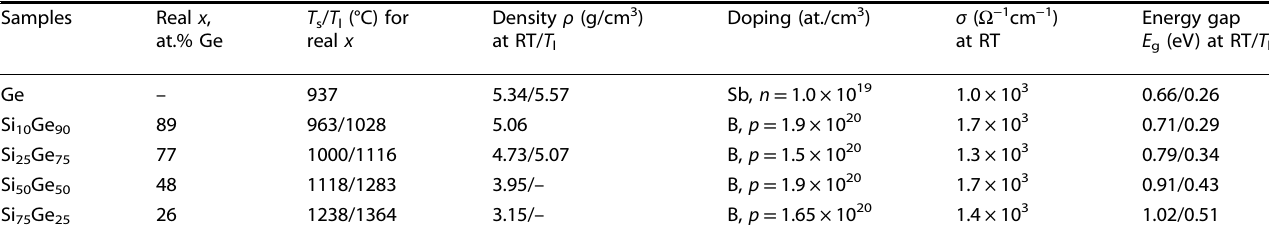
Table 1. Solidus and liquidus temperatures T s / T l , dopant concentration and electrical conductivity σ as well as energy gaps E g of Si 1 − x Ge x semiconductor samples used T s / T l (°C) for Density ρ (g/cm 3 ) Doping (at./cm 3 ) σ ( Ω − 1 cm − 1 ) Energy gap Samples Real x , real x at RT/ T l at.% Ge